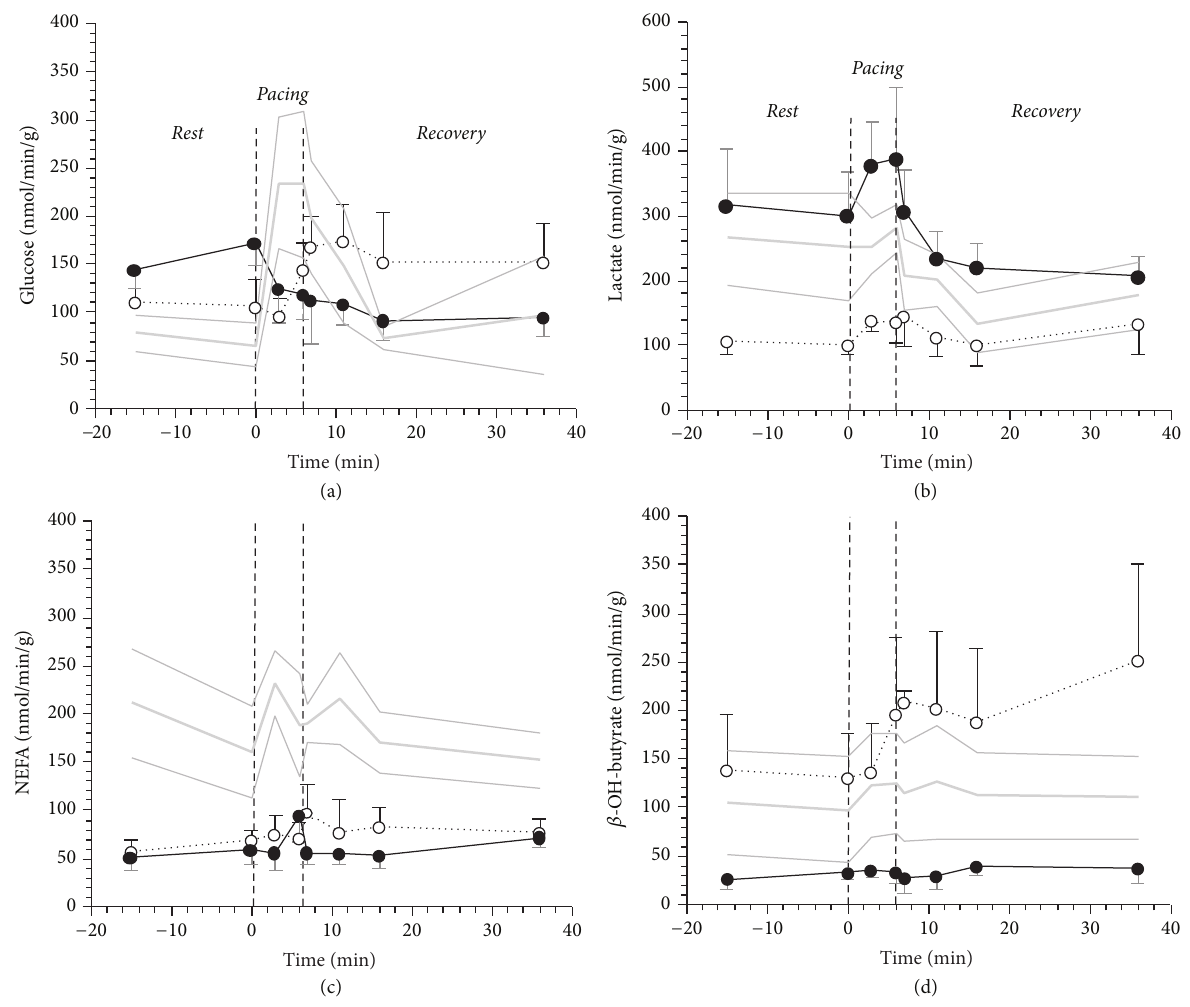
Figure 2: Cardiac glucose (a), lactate (b), NEFA (c), and 𝛽 -OH-butyrate (d) uptake in 5 N-AGT (gray line), 5 DCM-NGT (dotted black line), and 5 DCM-AGT (continuous black line) in the 3 phases of the study protocol: Rest , Pacing , and Recovery. The plotted values are mean ± SEM. The thin gray lines represent the SEM of the N-AGT group.